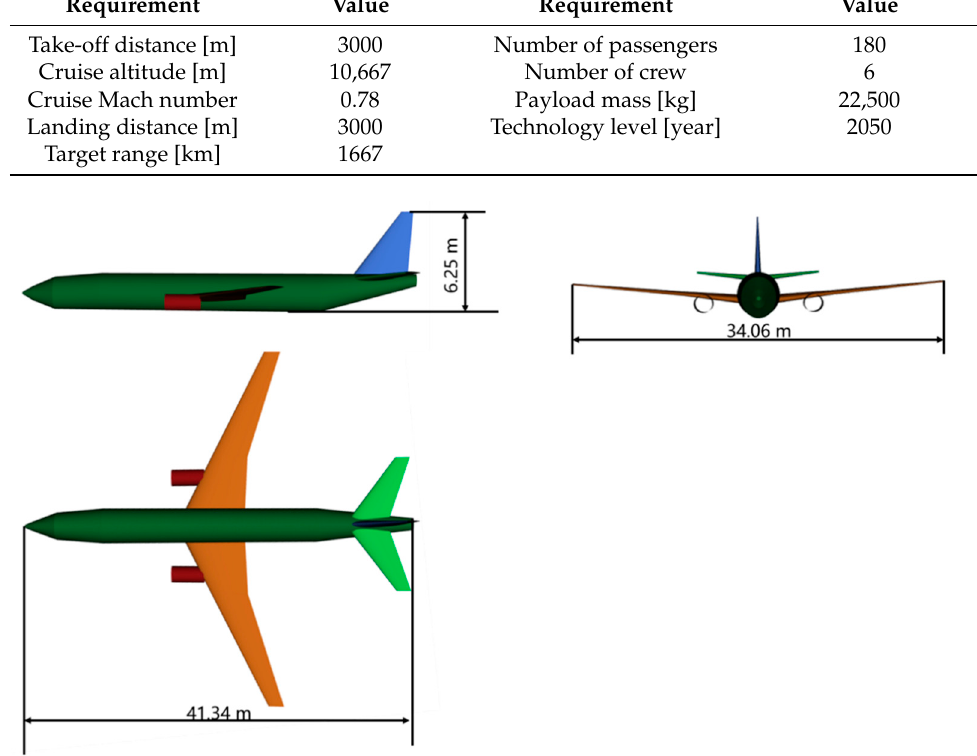
Figure 6. Three-view drawing of the baseline design.